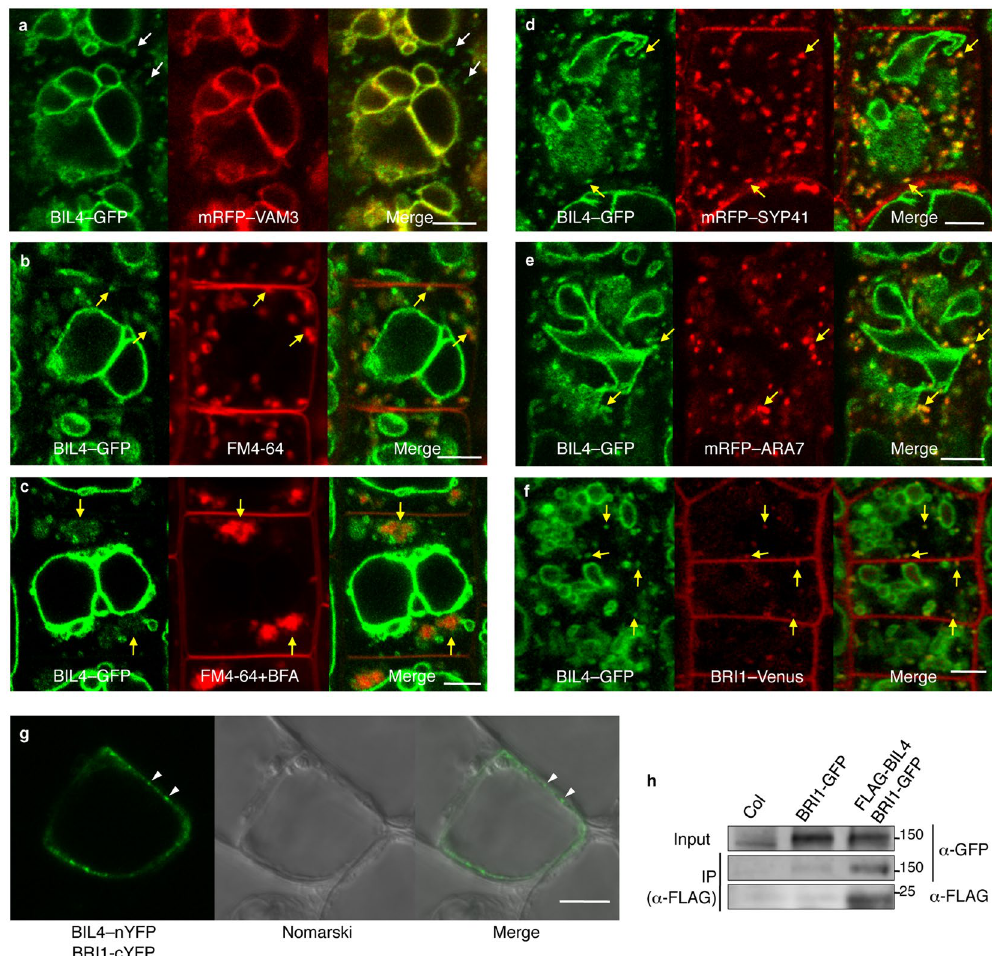
Figure 5. BIL4 is localized to punctate structures and the vacuolar membrane and interacts with BRI1. ( a ) BIL4 pro::BIL4–GFP partially co-localizes with the vacuolar membrane marker mRFP–VAM3 (unmerged puncta are marked by white arrows). ( b ) BIL4 pro::BIL4–GFP partially colocalizes with FM4-64. Seedlings were treated with FM4-64 for 5 min and then incubated in water for 40 min. ( c ) Seedlings were pretreated with FM4- 64 for 5 min, incubated in water for 20 min and then treated with 50 μ M BFA for 20 min. ( d – f ) BIL4 pro::BIL4– GFP partially co-localizes with the TGN/EE marker mRFP–SYP41 ( d ), the LE/MVB marker mRFP–ARA7 ( e ) and BRI1 pro::BRI1–Venus in the endosome ( f ). Merged structures in b–f are marked by yellow arrows. Scale bar in ( a–f ): 5 µ m. ( g ) BiFC assay of the interactions between BIL4 and BRI1 in cultured Arabidopsis cells. Scale bars, 10 μ m. The white arrowheads indicate characteristic interactions. ( h ) Co-immunoprecipitation of BRI1 and BIL4. Wild-type (Col-0) and transgenic plants coexpressing BRI1 pro::BRI1–GFP and 35 S::FLAG–BIL4 were grown for 7 days. FLAG–BIL4 was immunoprecipitated by anti-FLAG antibody, and the immunoblots were probed with anti-GFP or anti-FLAG